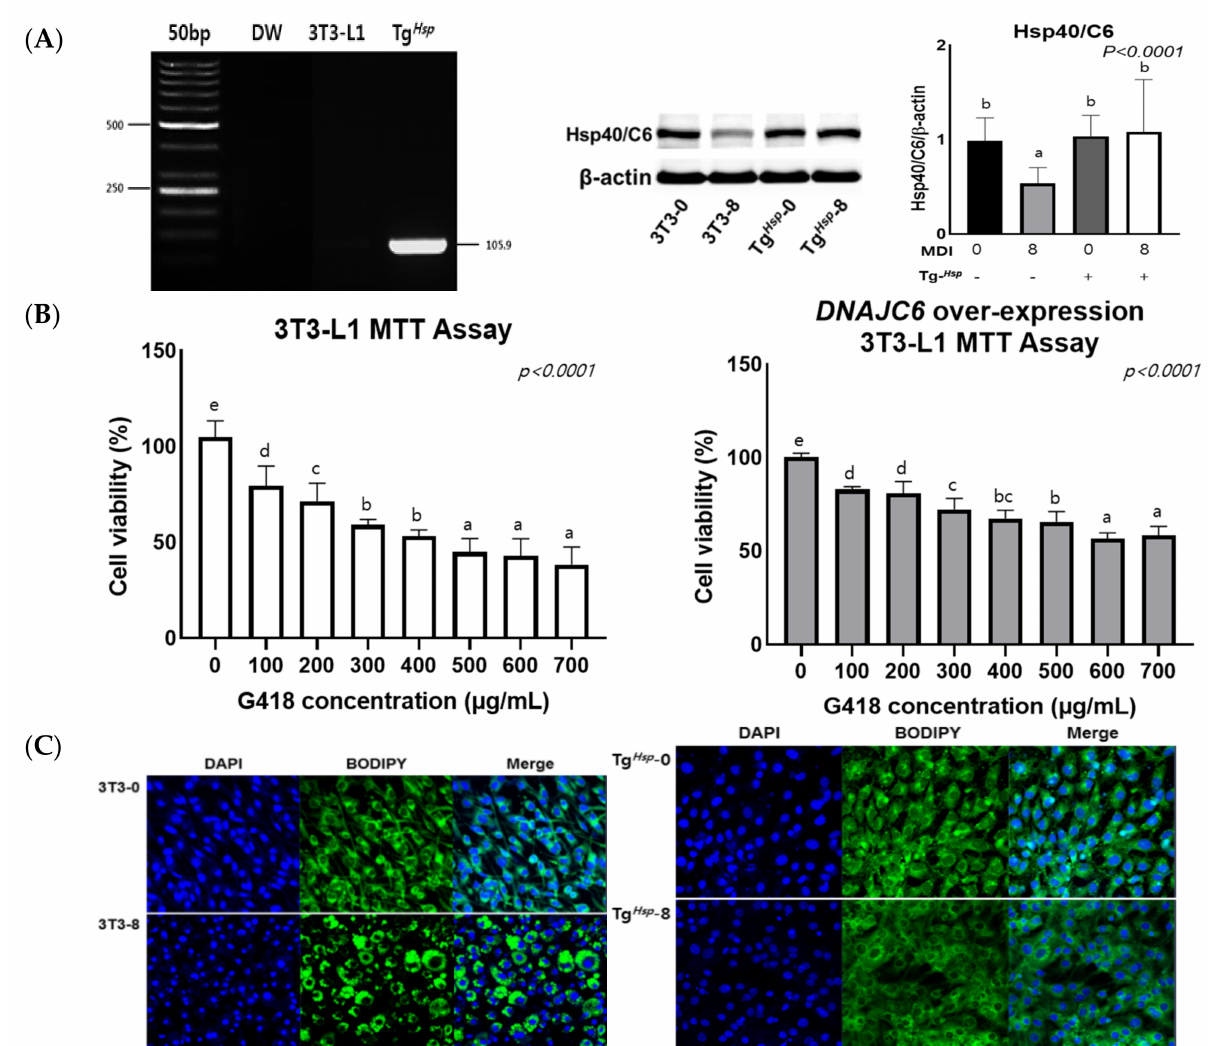
Figure 1. mRNA and protein expression of DNAJC6 ( A ), and cell viability ( B ) in Tg Hsp cells compared to that in 3T3-L1 cells without nucleus impairment ( C ). Data were assessed by one-way ANOVA with Duncan’s test. Superscript letters (a, b, c, and d) indicate significant differences between groups at p <